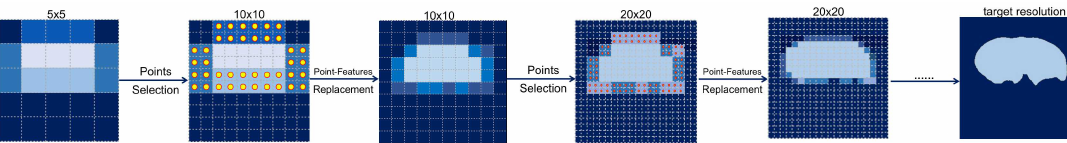
Figure 5. Example of the coarse-to-fine process. First, a coarse mask on a 5 × 5 grid is predicted by the coarse decoder. Next, the N most uncertain points (dots in grids) are selected to recover detail on the finer grid. Finally, these point-features are extracted and then used to replace the original features extracted by the encoder.